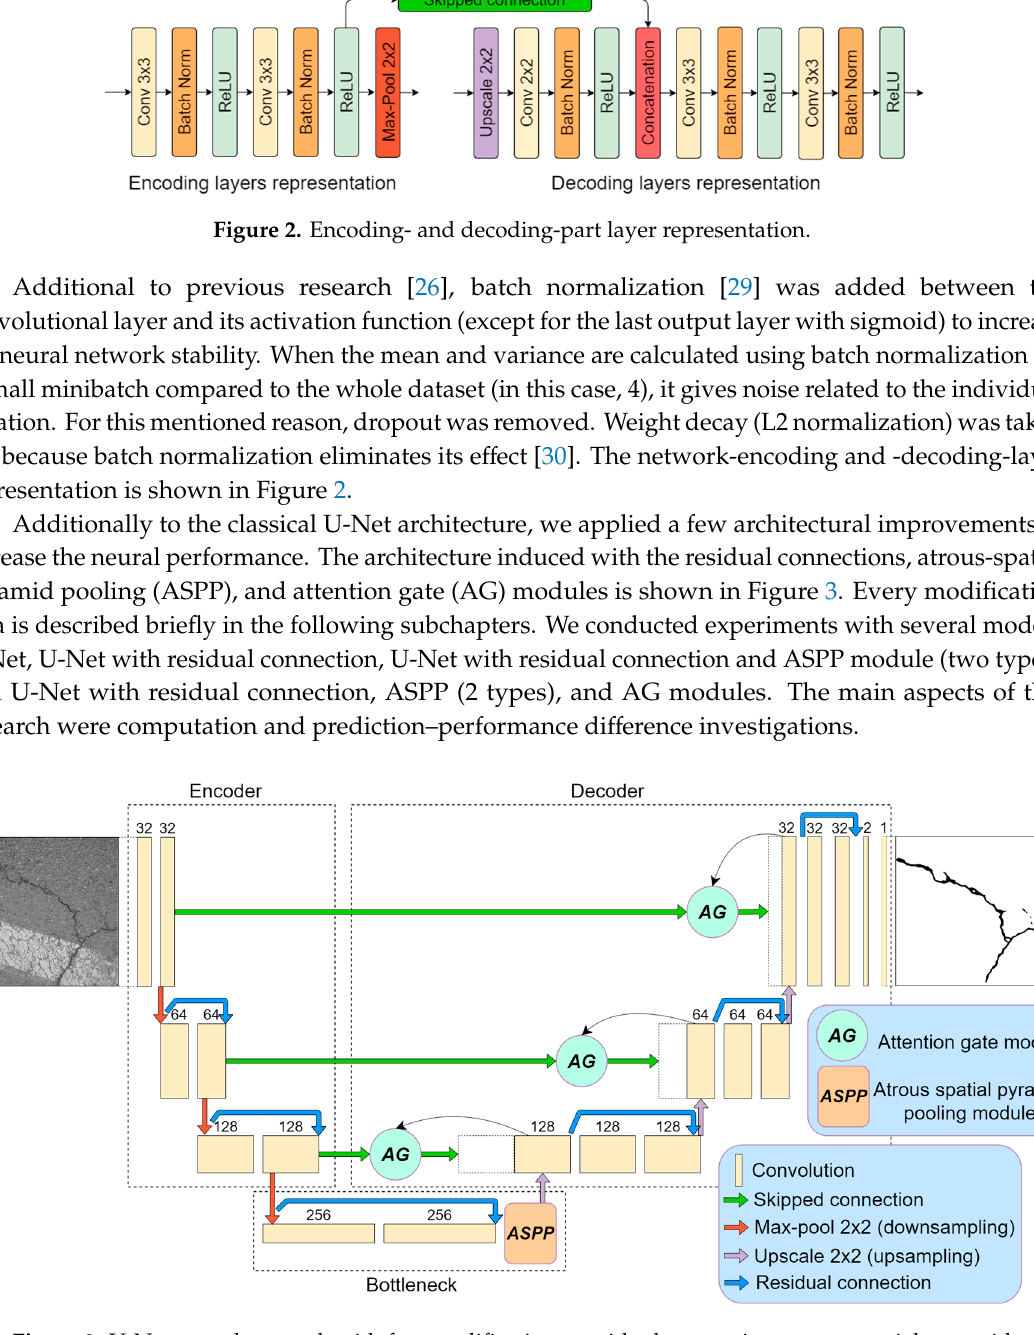
Figure 3. U-Net neural network with few modifications: residual connection, atrous spatial pyramid pooling (ASPP), and attention gate (AG) modules.